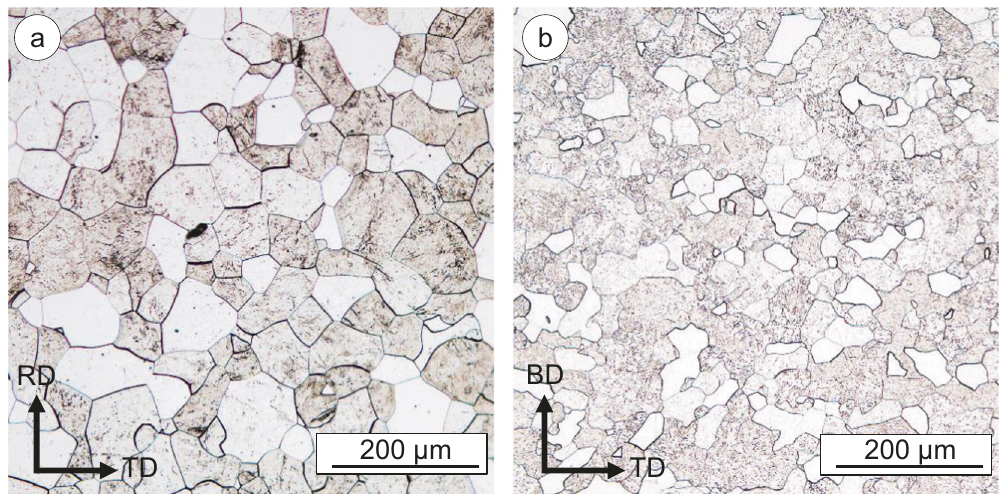
Fig. 1 Micrographs of the two material states. a HR iron, b EBM iron with rolling direction (RD), building direction (BD) and transverse direction (TD) marked in the fi gures.